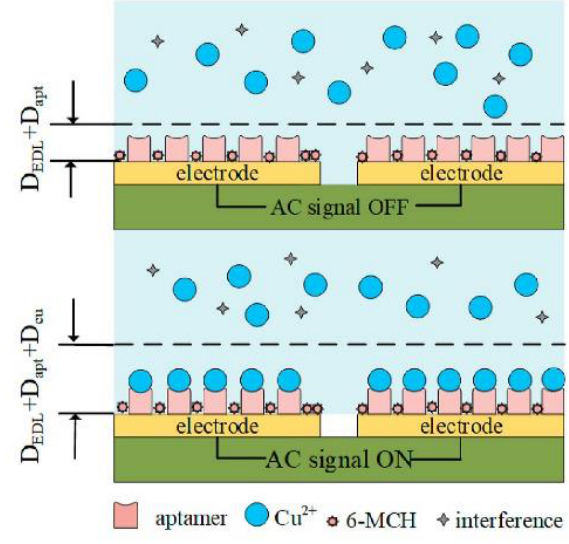
Figure 20. Scheme of the copper ions electrochemical sensor with the gold-plated coplanar electrode array. Adapted with permission from Qi et al. [86] (Copyright © (2021) Elsevier.